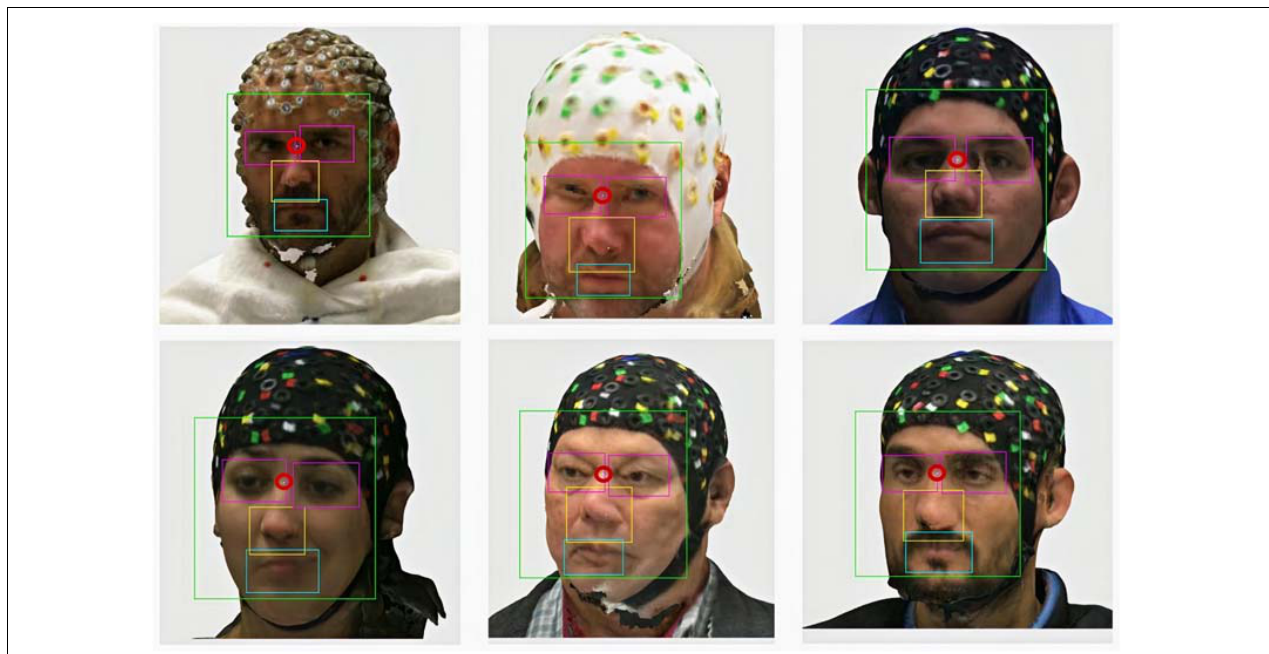
FIGURE 11 | Facial feature detection and nasion location